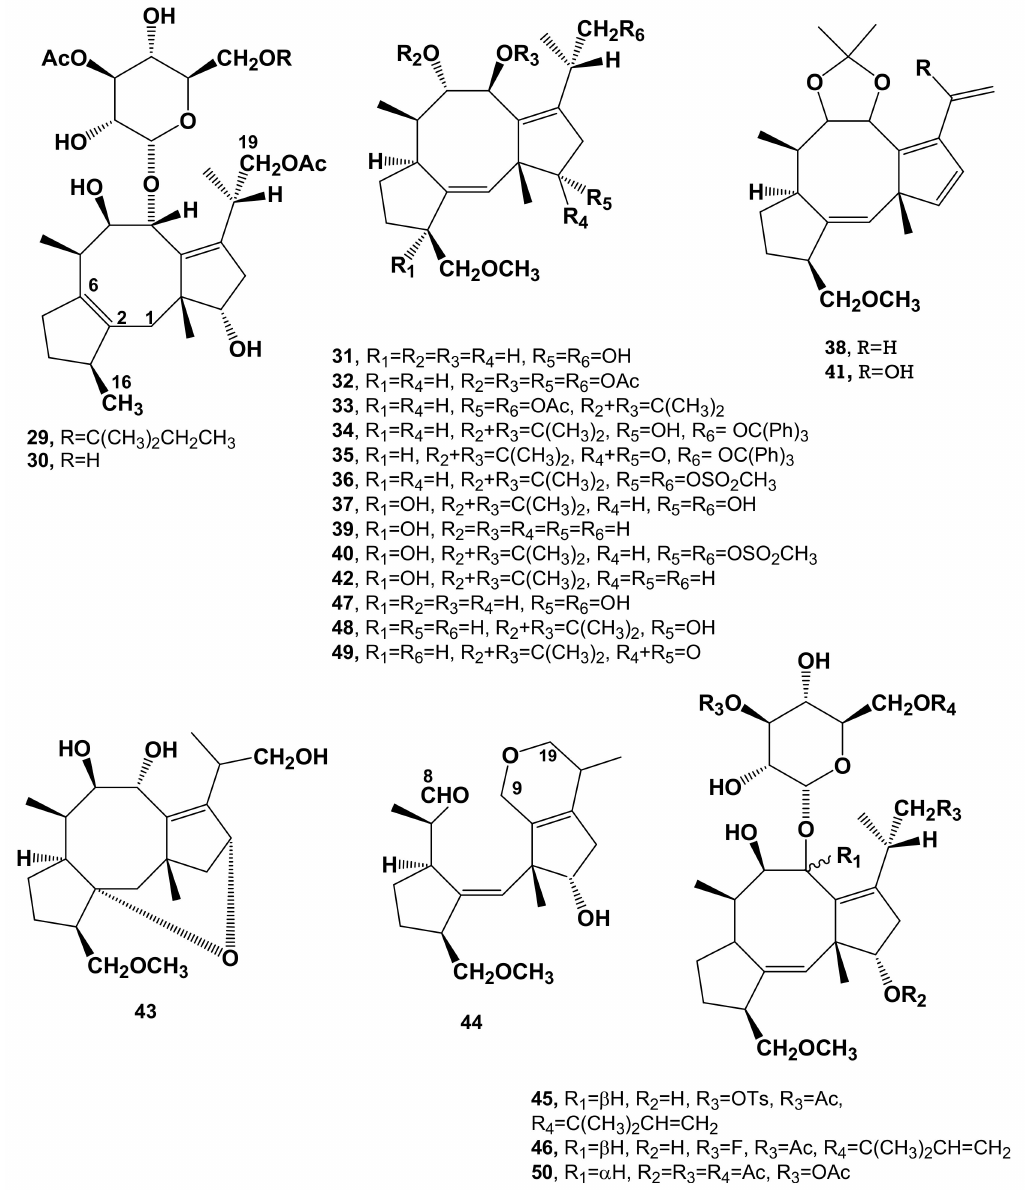
Figure 3. Chemical structures of other minor diterpenoid metabolites isolated from culture filtrates of P. amygdali , FC semisynthetic derivatives, and cotylenol, used in the biosynthetic and structure-activity relationship